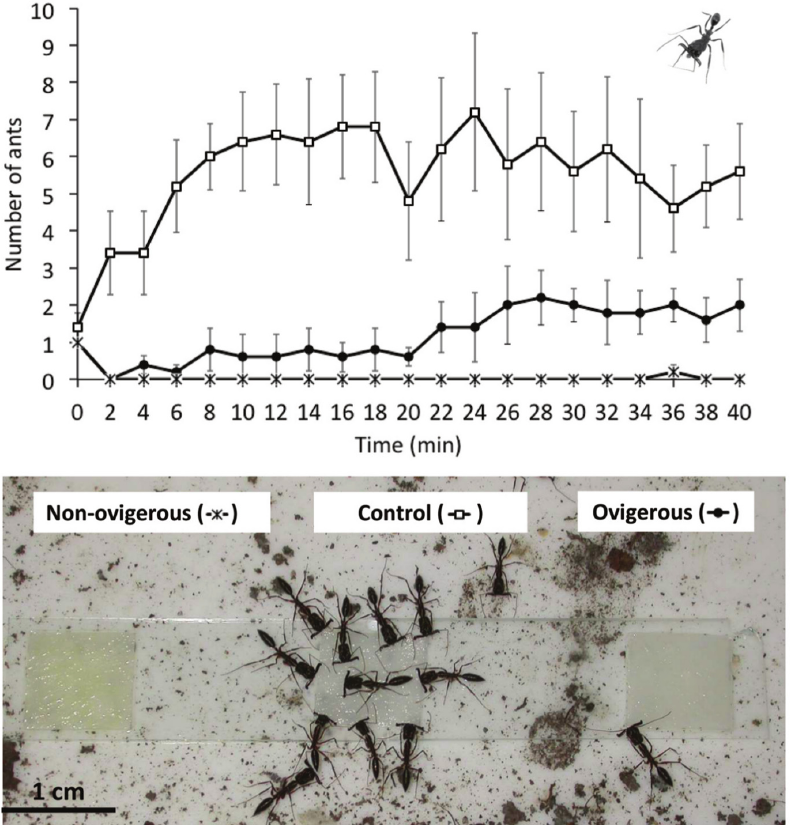
Fig 4. Mean ( ± SE) number of workers of the ants Odontomachus chelifer and Pachycondyla striata tending three types of baits: (1) sugar solution + secretion of one non-ovigerous female of Acutisoma longipes , (2) sugar solution + secretion of one ovigerous female of A . longipes . and (3) sugar solution (control). The photo illustrates the experimental setup of an O . chelifer colony at 14 min of